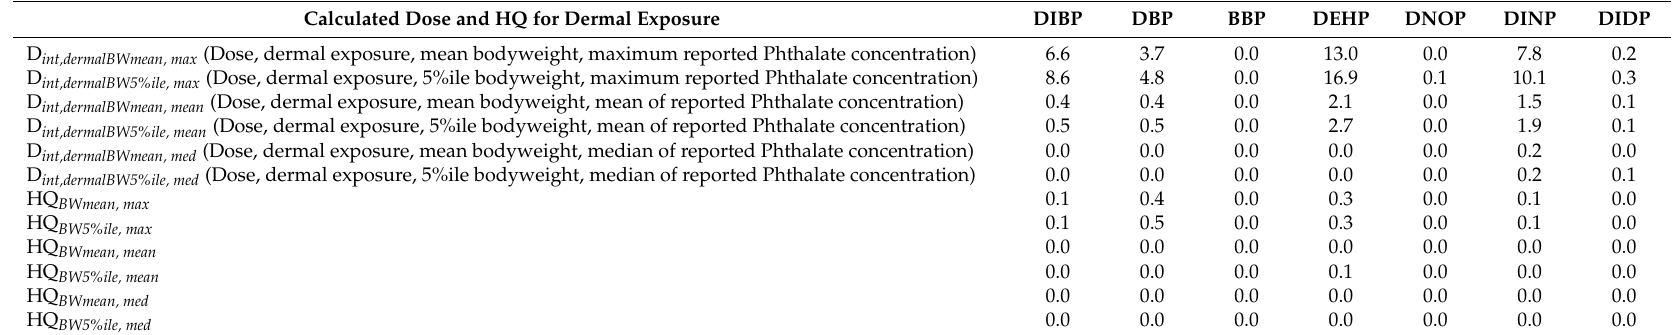
Table 5. Calculated dose ( µ g/kg bw/day) and HQ for dermal exposure to phthalates at maximum, mean and median exposure concentrations. Calculated Dose and HQ for Dermal Exposure DIBP DBP BBP